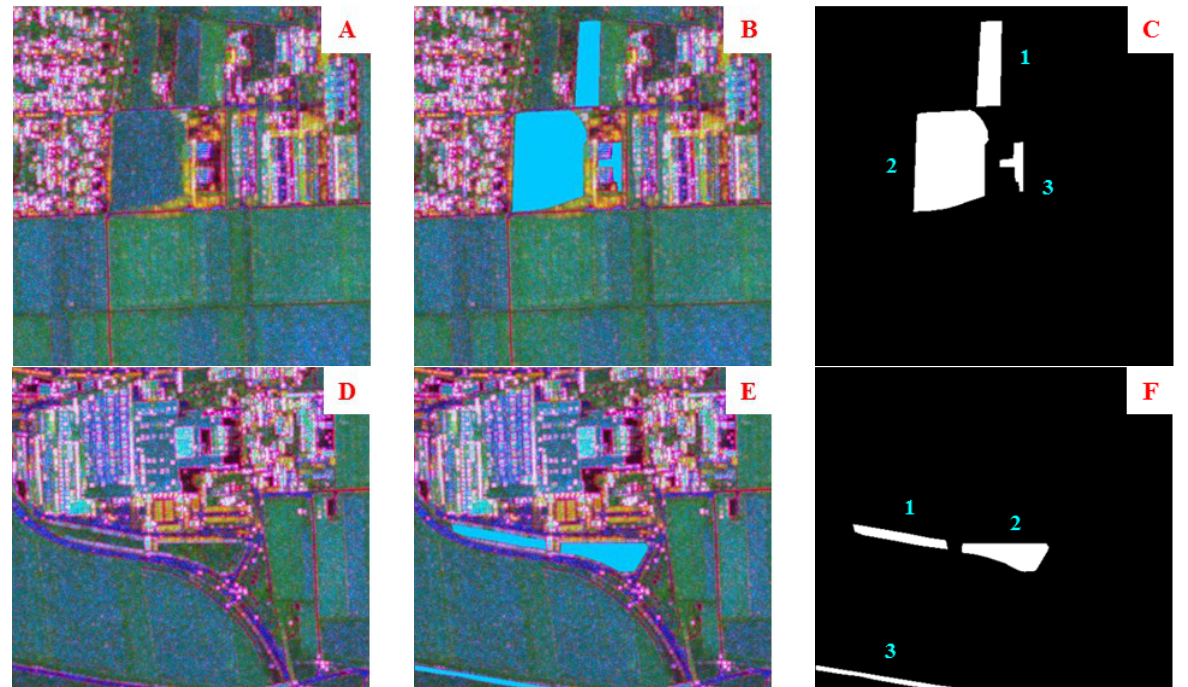
Figure 3: Reference segments. Input CovAmCoh patches (A, D); selected, cyan colored reference segments in CovAmCoh patches (B, E) and reference segments as foreground in binary image patches (C,